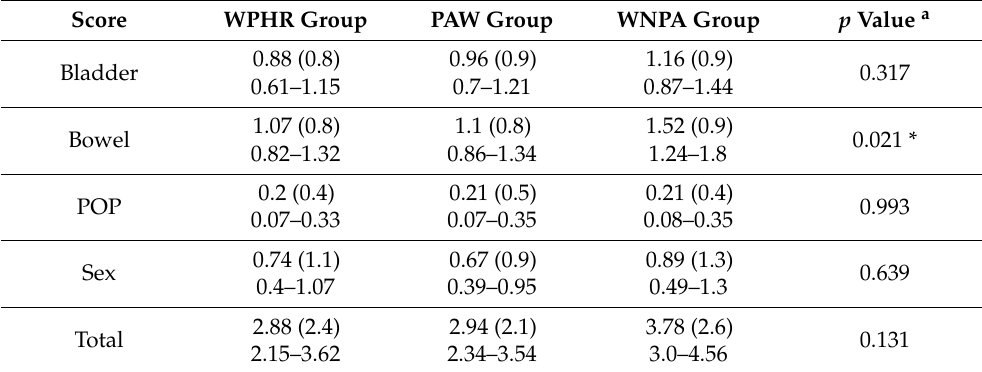
Table 2. Comparison of scale scores between the